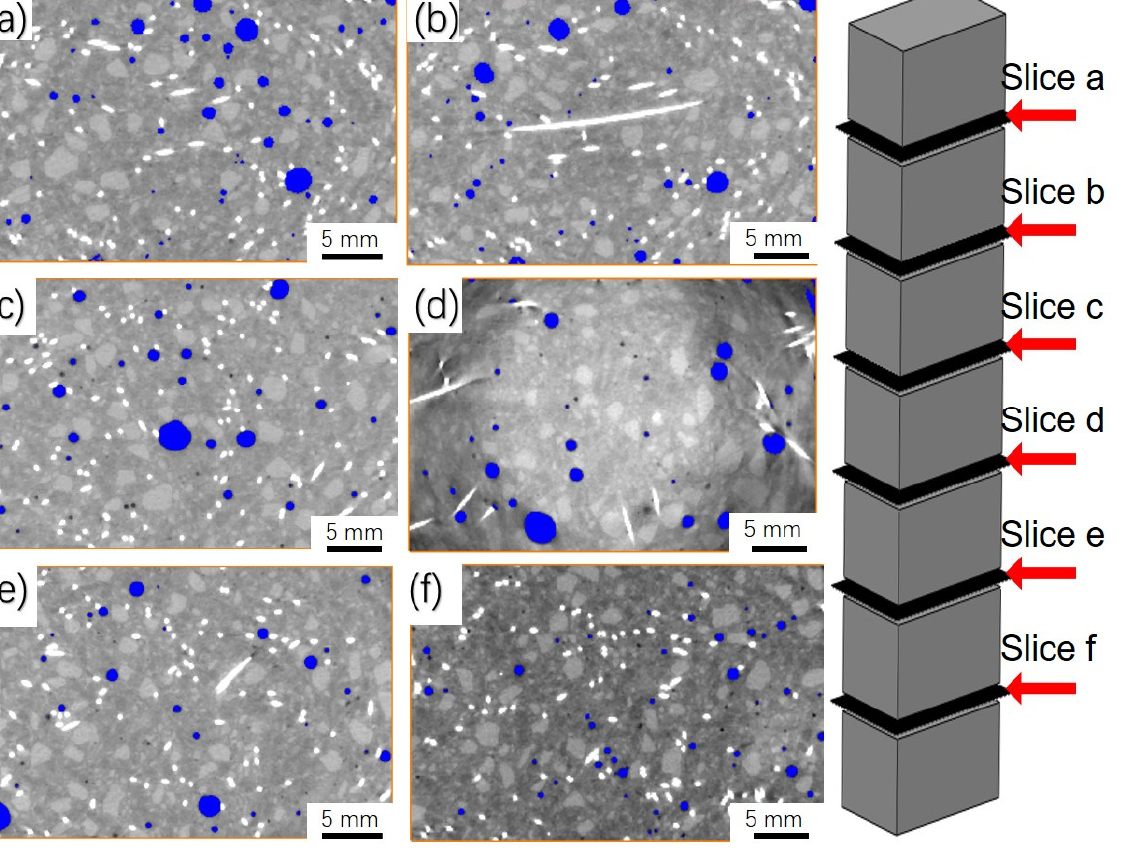
Figure 11. From the top to the bottom, the reconstructed 3D image of 6 wt.% straight BCSF-reinforced UHPC at 28 days: ( a ) slice a; ( b ) slice b; ( c ) slice c; ( d ) slice d; ( e ) slice e; ( f ) slice f.